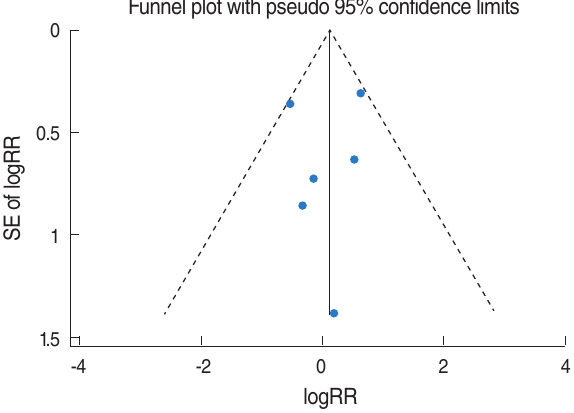
Figure 2. A funnel plot using fixed-effects summary estimates in